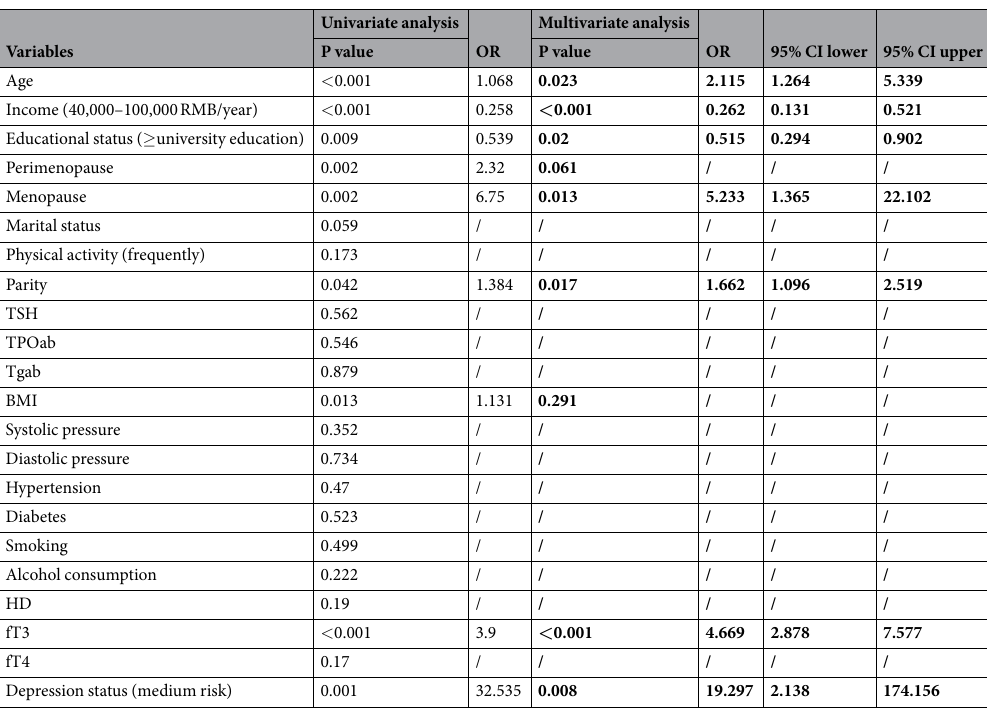
Table 3. Risk factor identification. fT3: free triiodothyronine; fT4 : free thyroxine; TPOab : thyroid peroxidase antibody; Tgab : thyroglobulin antibody; TSH: thyroid stimulating hormone; BMI: body mass index. P < 0.05 indicates a significant